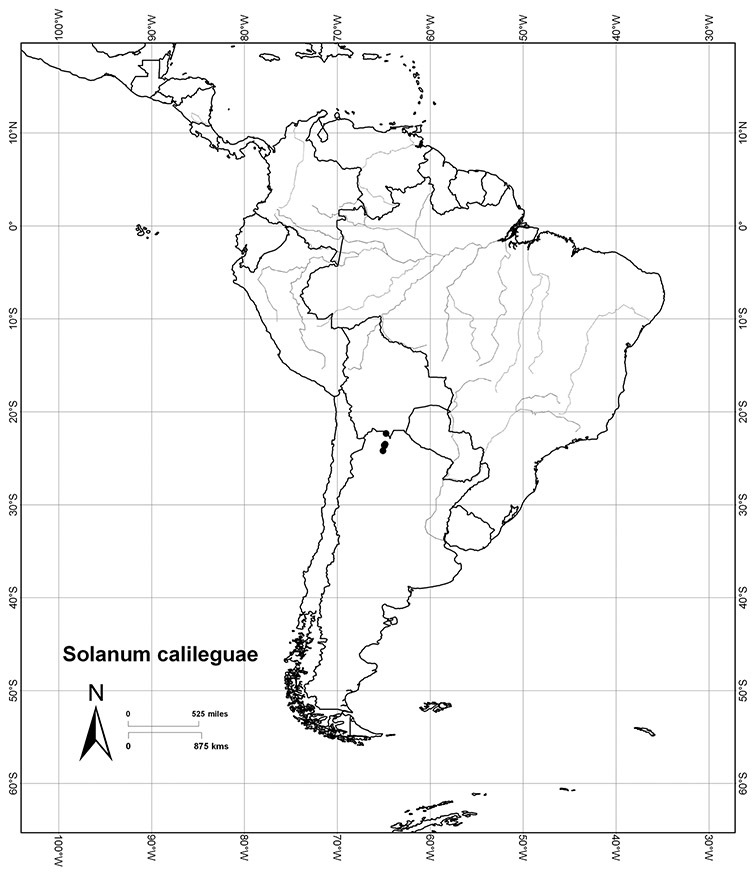
Distribution of Solanum calileguae Cabrera.